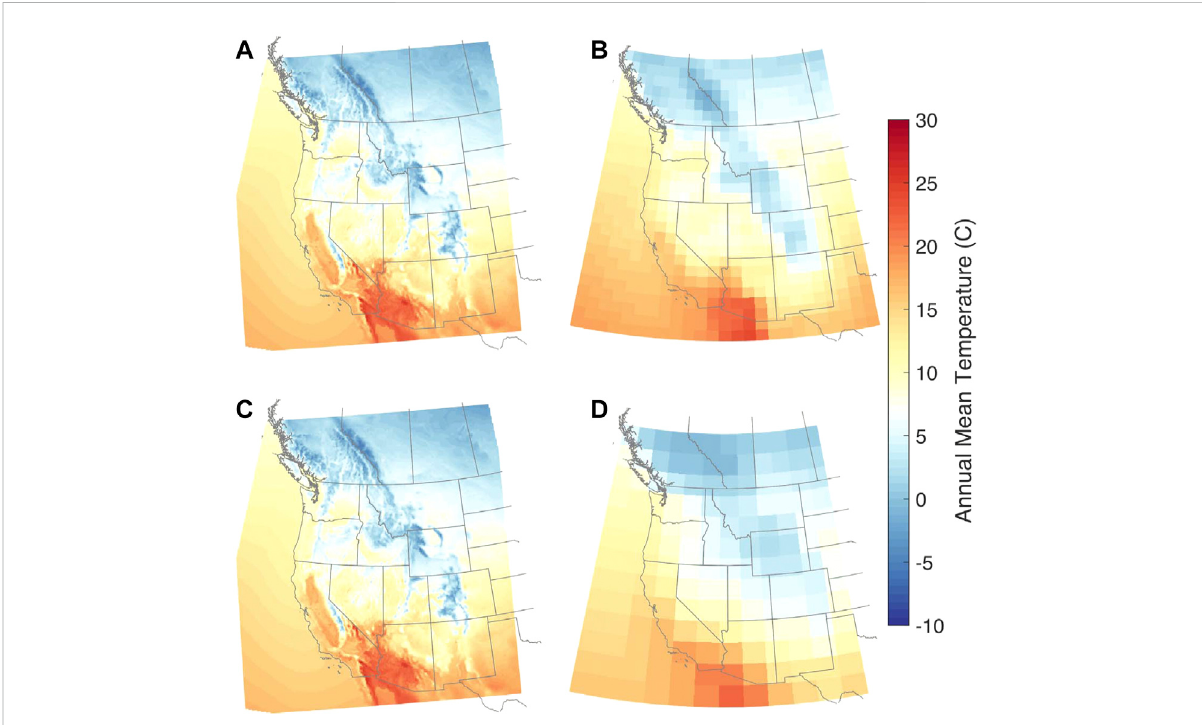
FIGURE 1 Comparisonofannualmeantemperature,averagedoverthehistoricaldecade(wateryears1996 – 2005)from (A,B) CCSM4and (C,D) NorESM1- M. The WRF estimates (A,C) are at 9 km spatial resolution and the GCM estimates (B,D) are at the GCM native